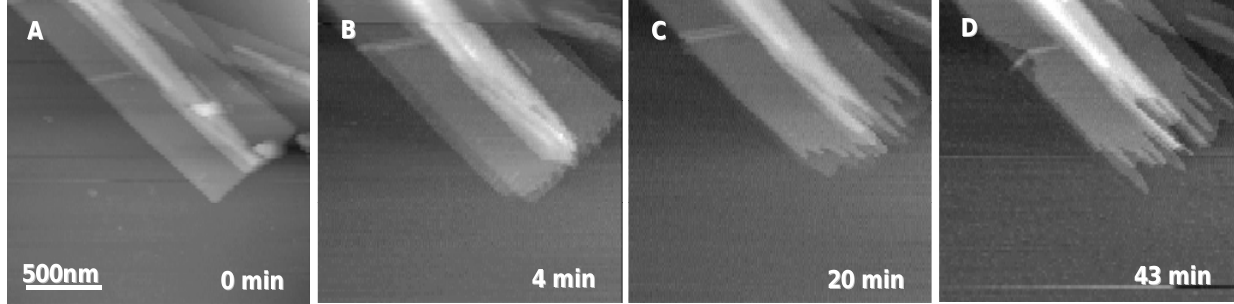
Figure 7. AFM amplitude images of PHA single crystals for (A) high-molecular-weight P(3HB) ( M n 240000), (B) middle-molecular-weight P(3HB) ( M n 55000), (C) low- molecular-weight P(3HB) ( M n 8500), (D) P(3HB- co -6mol%-3HV), and (E) P(3HB- co